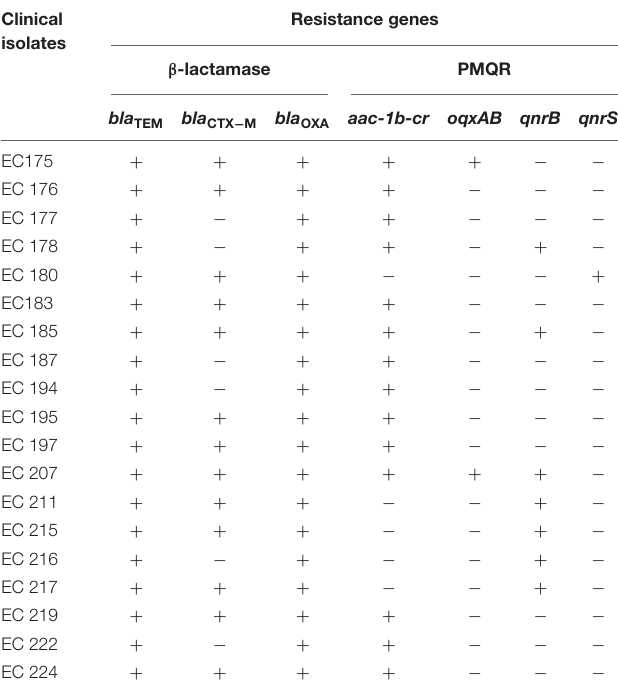
TABLE 2 | Resistance genes in the clinical uropathogenic E. coli isolates ( n = 19). Clinical